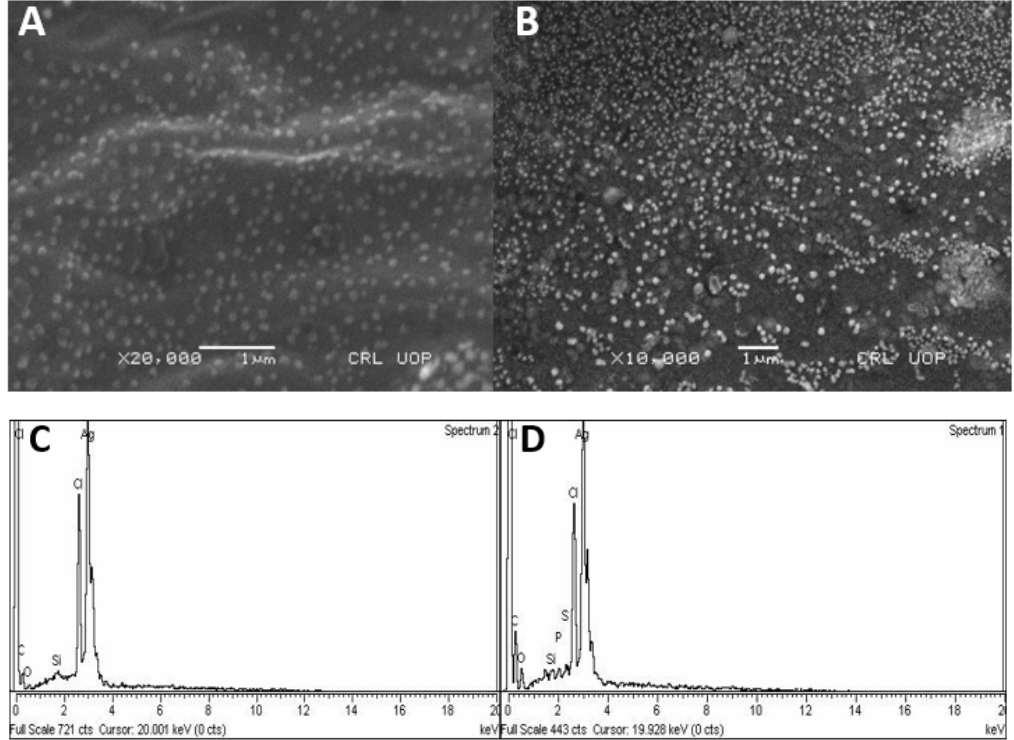
Figure 5. FTIR of leaf-capped AgNP ( A ) and bulb-capped AgNP ( B ) extracts of A. vittata . XRD anal- ysis of bulb ( C ) and leaf synthesized AgNPs ( D ) using A. vittata.